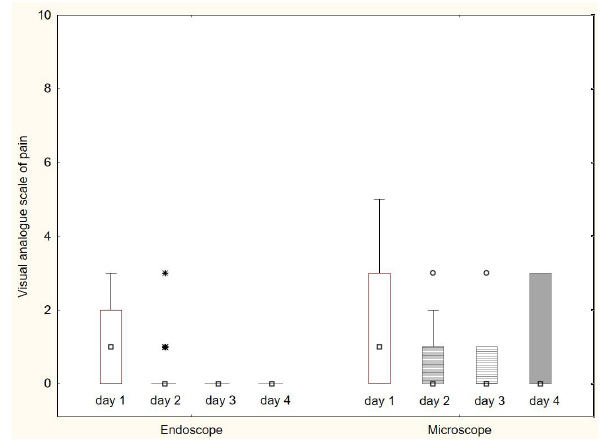
Fig. 2. A comparison of visual analogue scale of pain intensity after endoscopic and microscopic ear procedures in reconstruc- tion group.